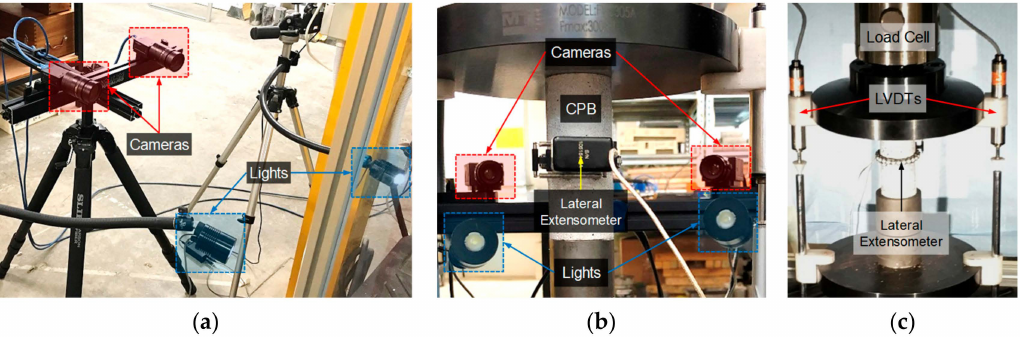
Figure 1. UCS + DIC testing system: ( a ) Two-camera stereo set-up; ( b ) Rear view of the experimental set-up during compressive loading; and ( c ) Front view of the experimental set-up during compressive